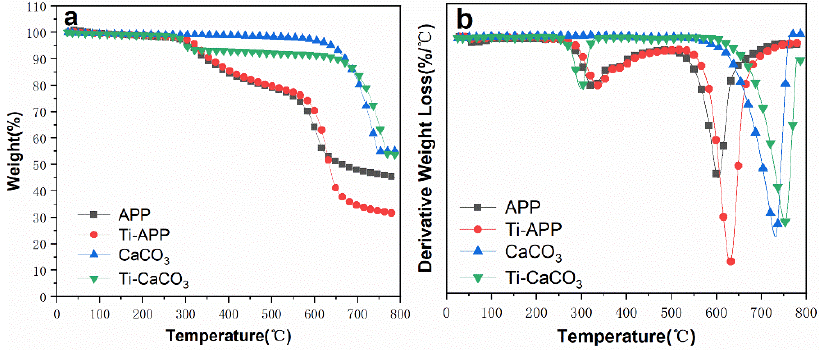
Figure 5. Thermogravimetric analysis of modified APP and CaCO 3 (a is TG curve and b is DTG curve). Table 2. Thermogravimetric data of modified APP and CaCO 3. Table 2. Thermogravimetric data of modified APP and CaCO